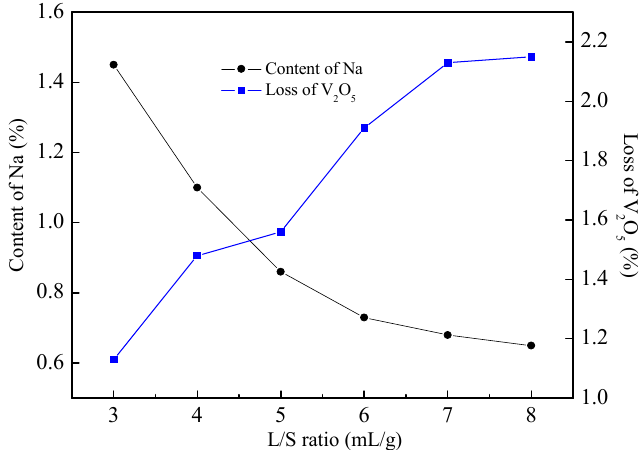
Figure 10. Effect of liquid to solid ratio on the washing of Na +.